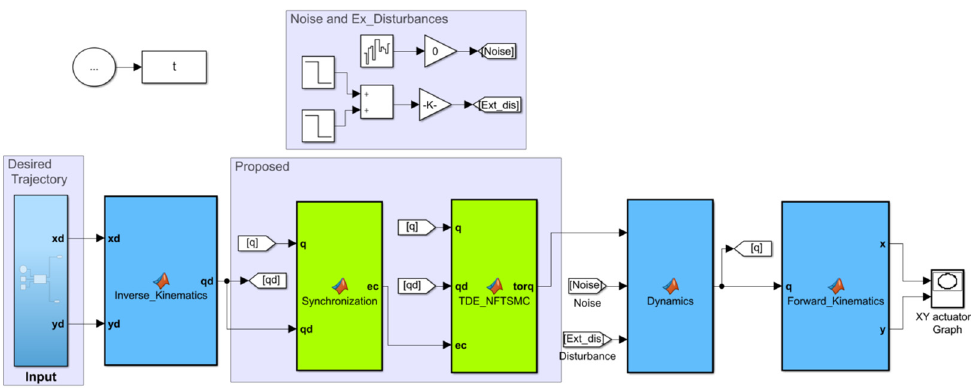
Figure 4. Control design in MatLab/ Simulink environment.